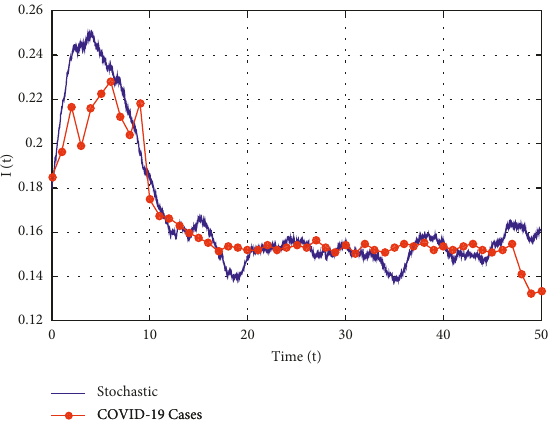
Figure 7: The response of the stochastic model (4) with the es- � 1 . 99854, 􏽢 β � 1 . 9813, 􏽢 β � 0 . 219092, timated parameters 􏽢 β 2 5 6 􏽢 κ � 0 . 01099, and 􏽢 r � 0 . 047, such that the intensities of white noises � 0 . 03, ] � 0 . 02, ] � 0 . 02, ] � 0 . 04, and ] � 0 . are ] 1 2 3 4 5